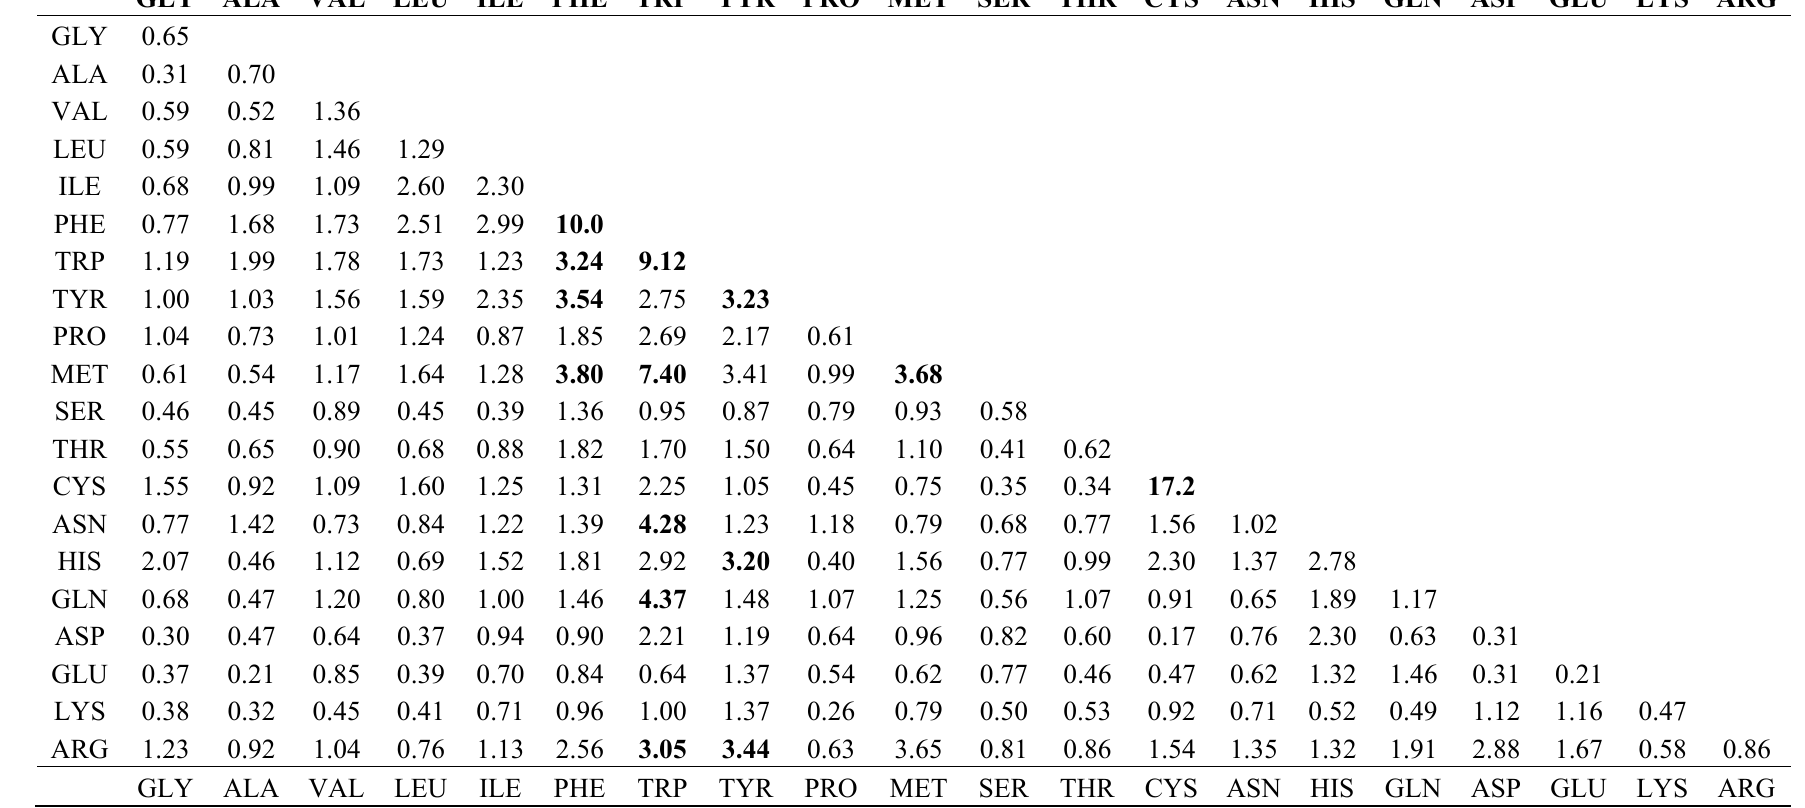
Table 2. Contact pair propensities normalized by surface